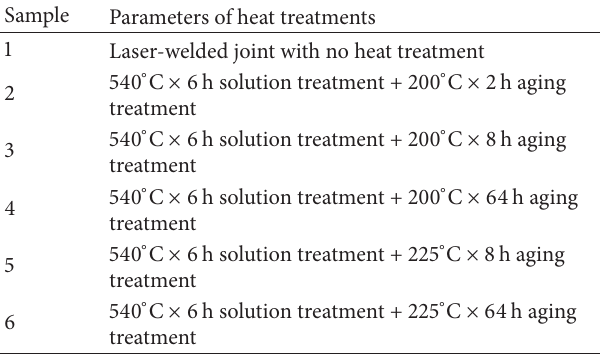
Table 2: Parameters of heat